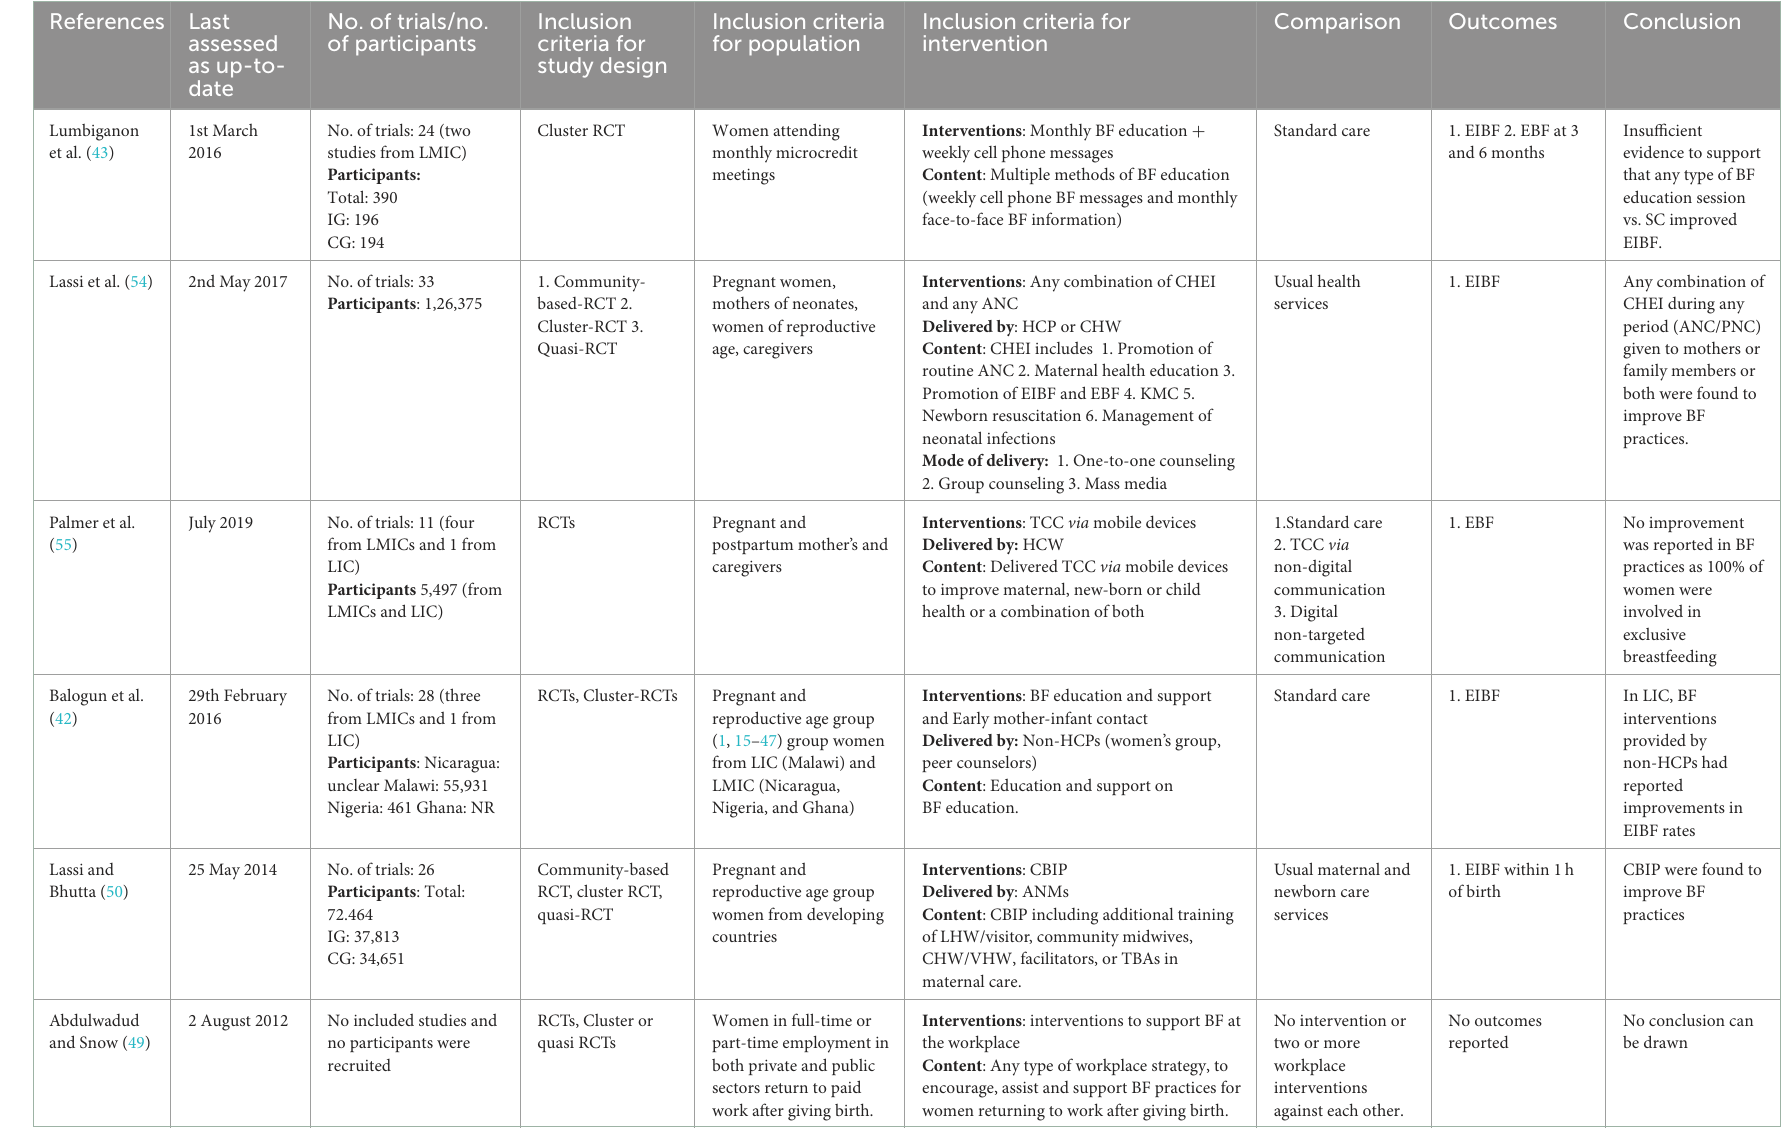
TABLE 1 Characteristics of included